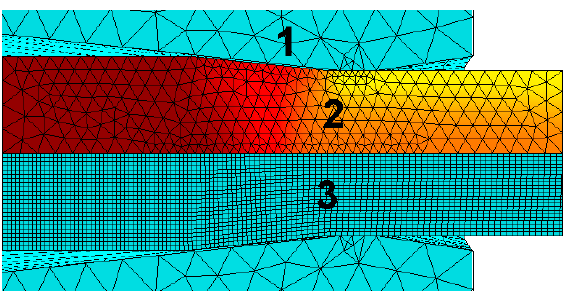
Figure 9. Mesh diagram for the heat-plastic solution and process visualization, 1—tool mesh, 2—deformation and plastic task mesh, 3—Lagrange mesh.